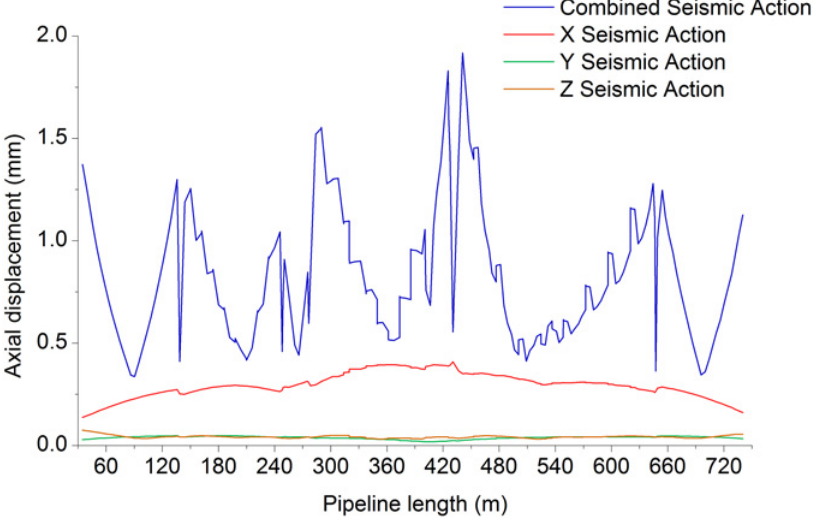
Fig 7. Pipeline axial displacement during seismic action.